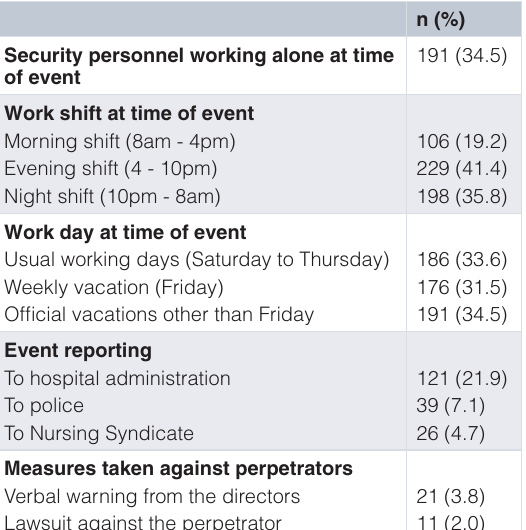
Table 4. Circumstances, including time of event and to whom events are reported, of 553 workplace violence events reported by security personnel at a university hospital in Egypt.